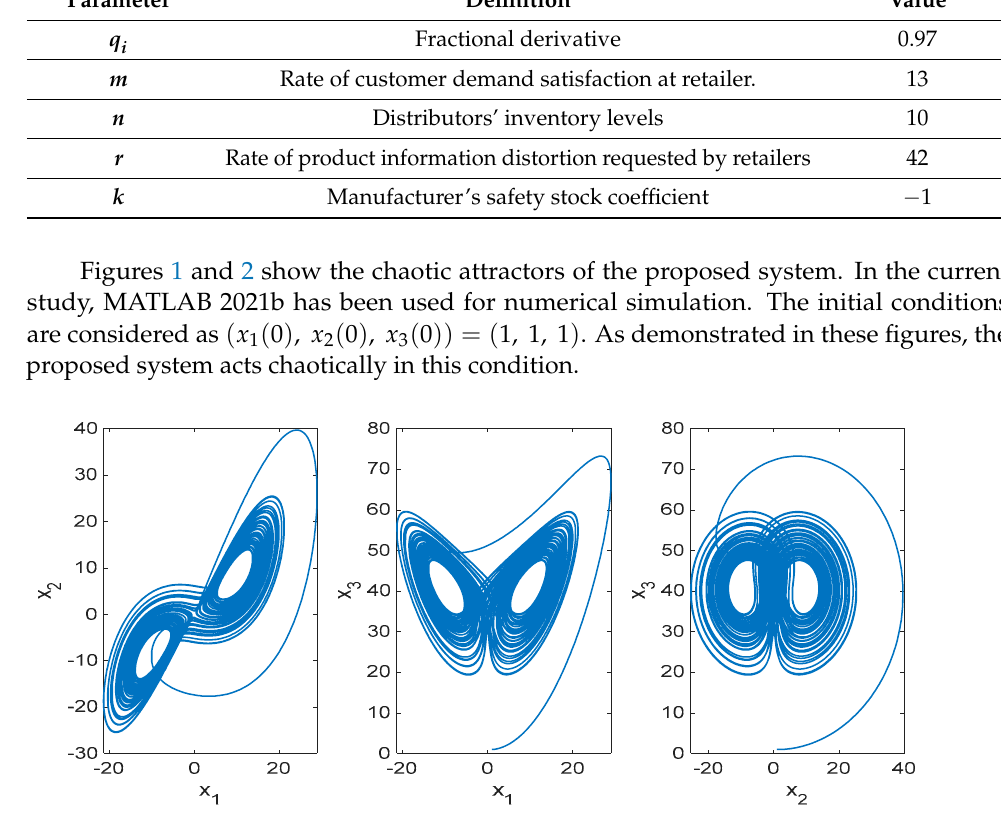
Figure 1. 2D phase diagram of the proposed fractional-order system.